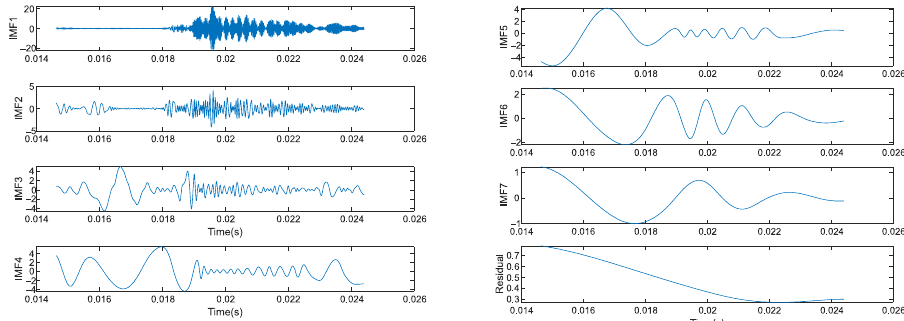
Figure 20. The EMD waveform of intercept signal.